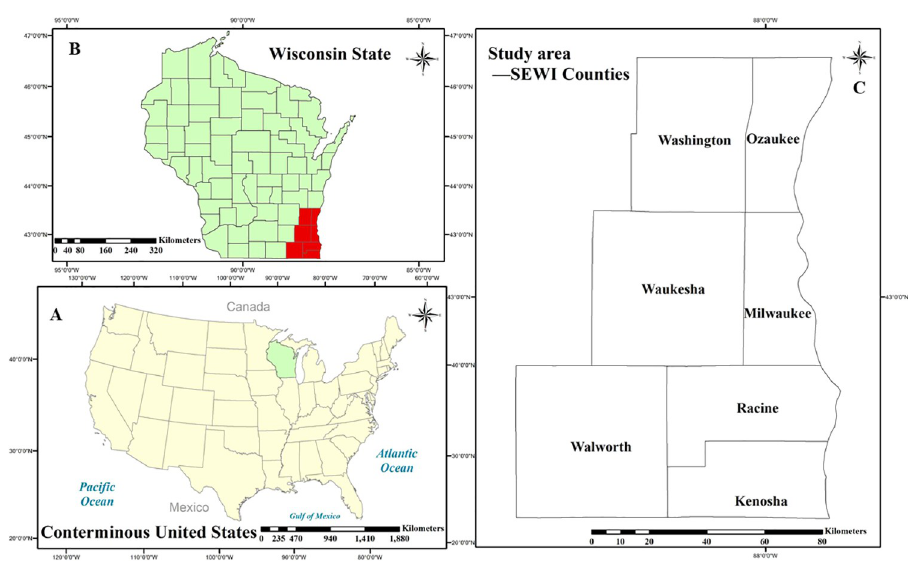
Fig 1. Location of southeastern Wisconsin (SEWI). (A) Wisconsin State in Conterminous United States.(B) Southeastern Wisconsin in Wisconsin State.(C) Counties in southeastern Wisconsin.